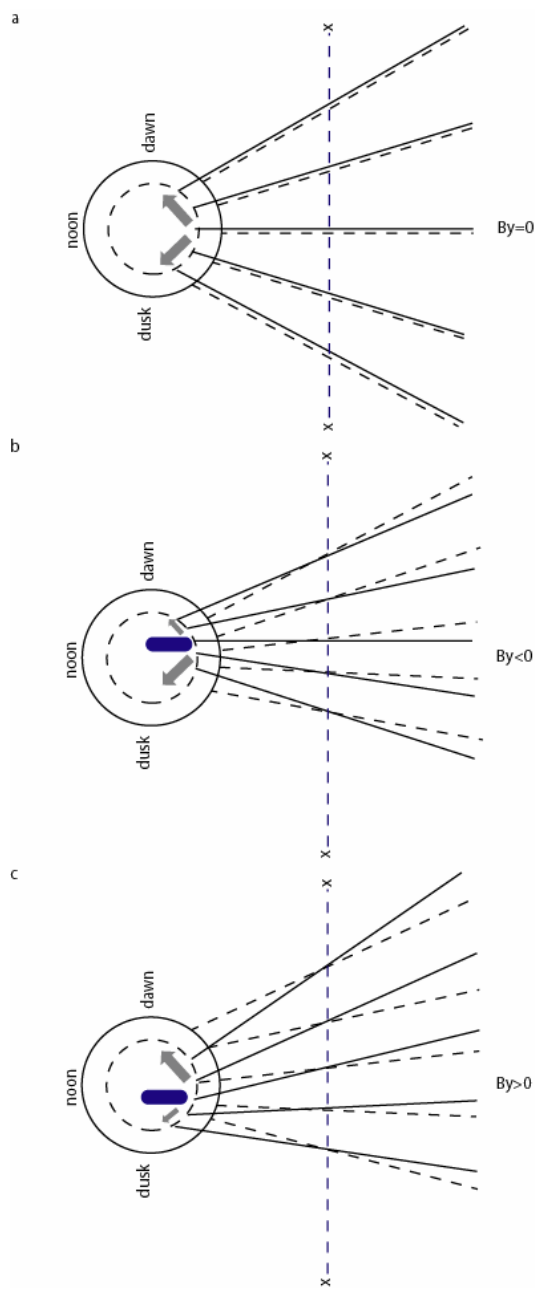
Fig. 6. Schematic diagrams to show the field topologies in the mag- netotail after reconnection for (a) IMF By =0 (b) By< 0 and (c) By> 0. Dashed circle indicates the polar cap, and solid (dotted) lines represent nightside field lines for the Northern an (Southern) Hemisphere. Convection return flows in the equatorial plane of the tail and in the ionosphere are shown using arrows. In Fig. 6b and c, opposing forces in the Northern and Southern hemispheres re- sults in the formation of transpolar arcs shown with blue rectangles (based on Fig. 6, Milan et al.,